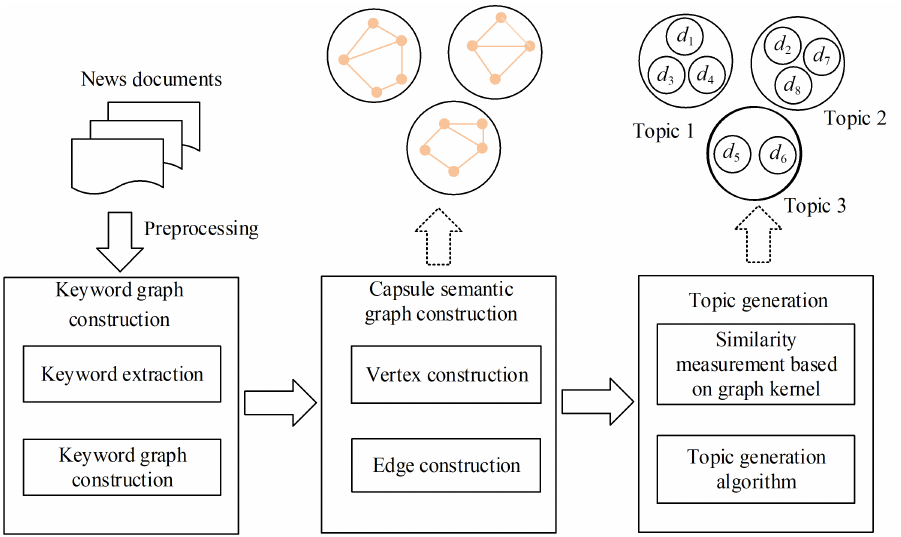
Fig. 1 Frame diagram of news topic detection model based on CSG. d i represents the i -th news document.